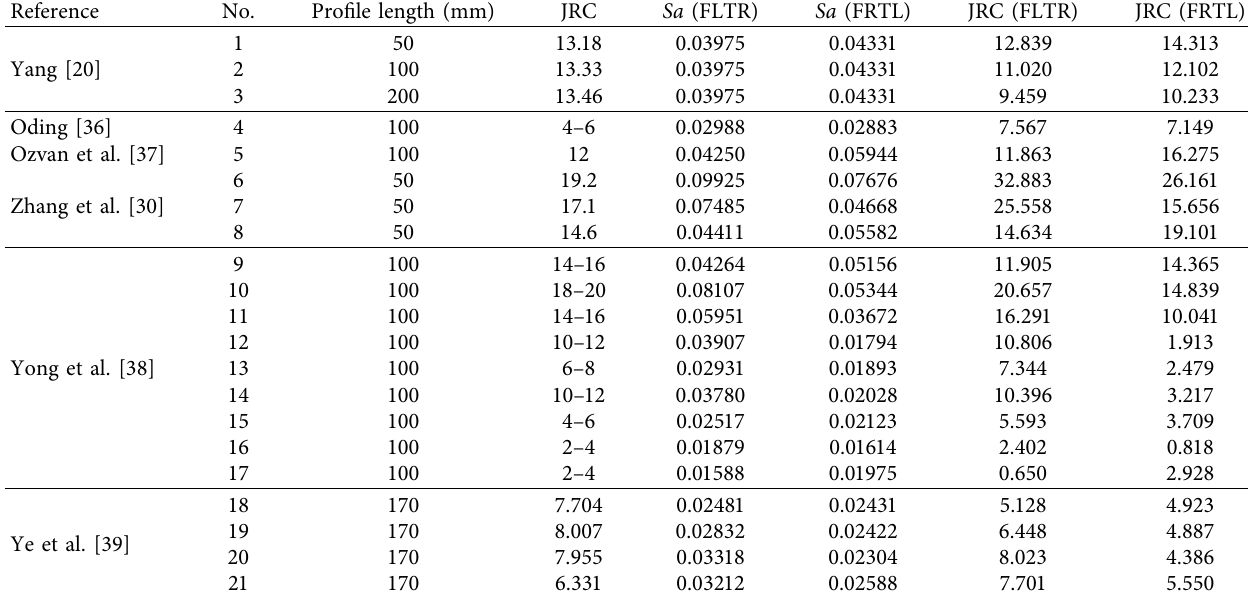
Table 7: The prediction of roughness for each joint profile using Sa